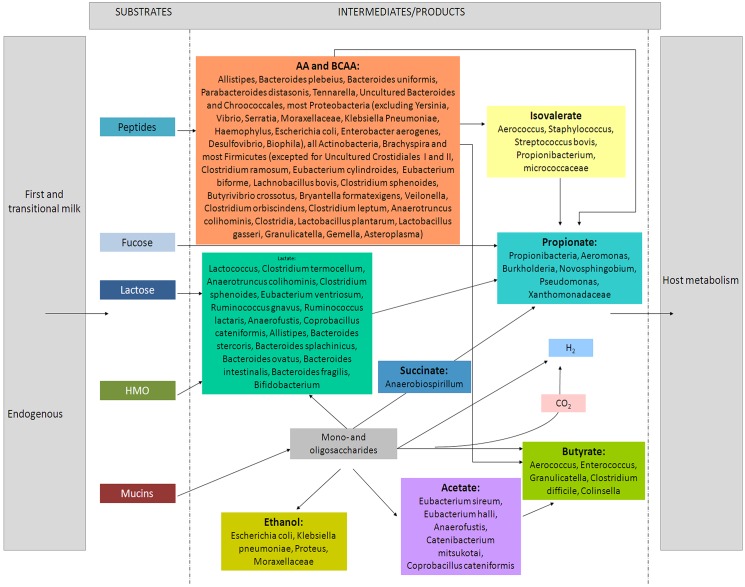
Model of microbial metabolism in perinatal babies under trophic pathways associated with transitional/mature milk.The integration of genomic and metabolomic pipelines suggests a functional picture of microbial metabolism, primed by transitional/mature milk trophic pathways, during early development.